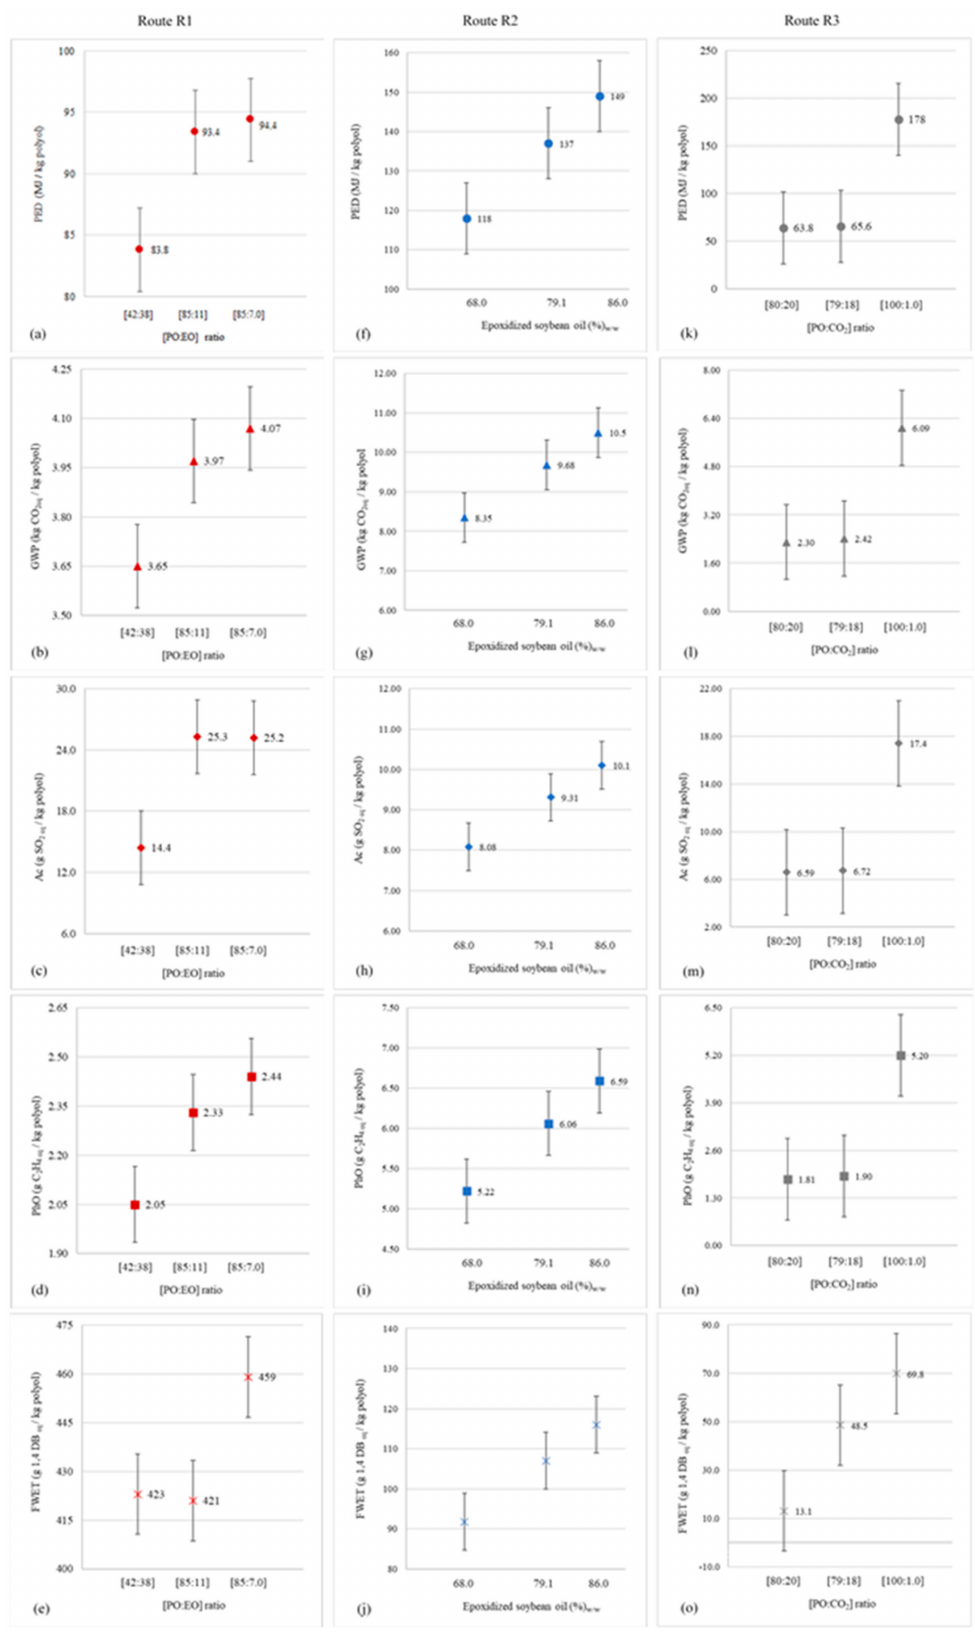
Figure 2. Behavior of the environmental performances of routes R1 ( a – e ), R2 ( f – j ), and R3 ( k – o ) due to the oscillation of parameters of significant influence on their impact